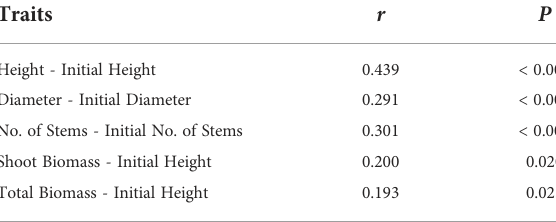
TABLE 2 Summary of correlation between initial and fi nal measurements of saltcedar on 5 phenotypic traits. r and P refer to correlation between the pair of variables and signi fi cance of the correlation respectively.